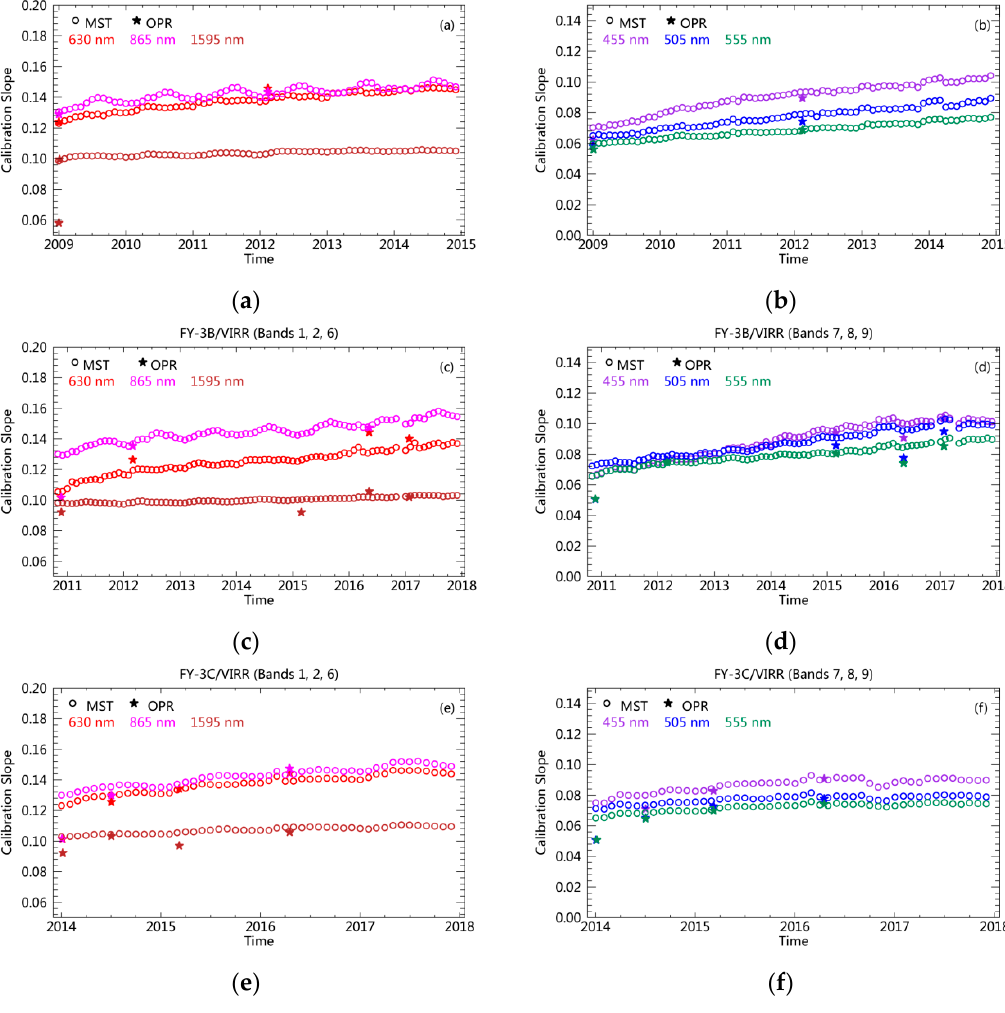
Figure 6. Time series of the calibration slopes for the VIRR onboard ( a , b ) FY-3A, ( c , d ) FY-3B, and ( e , f ) FY-3C.